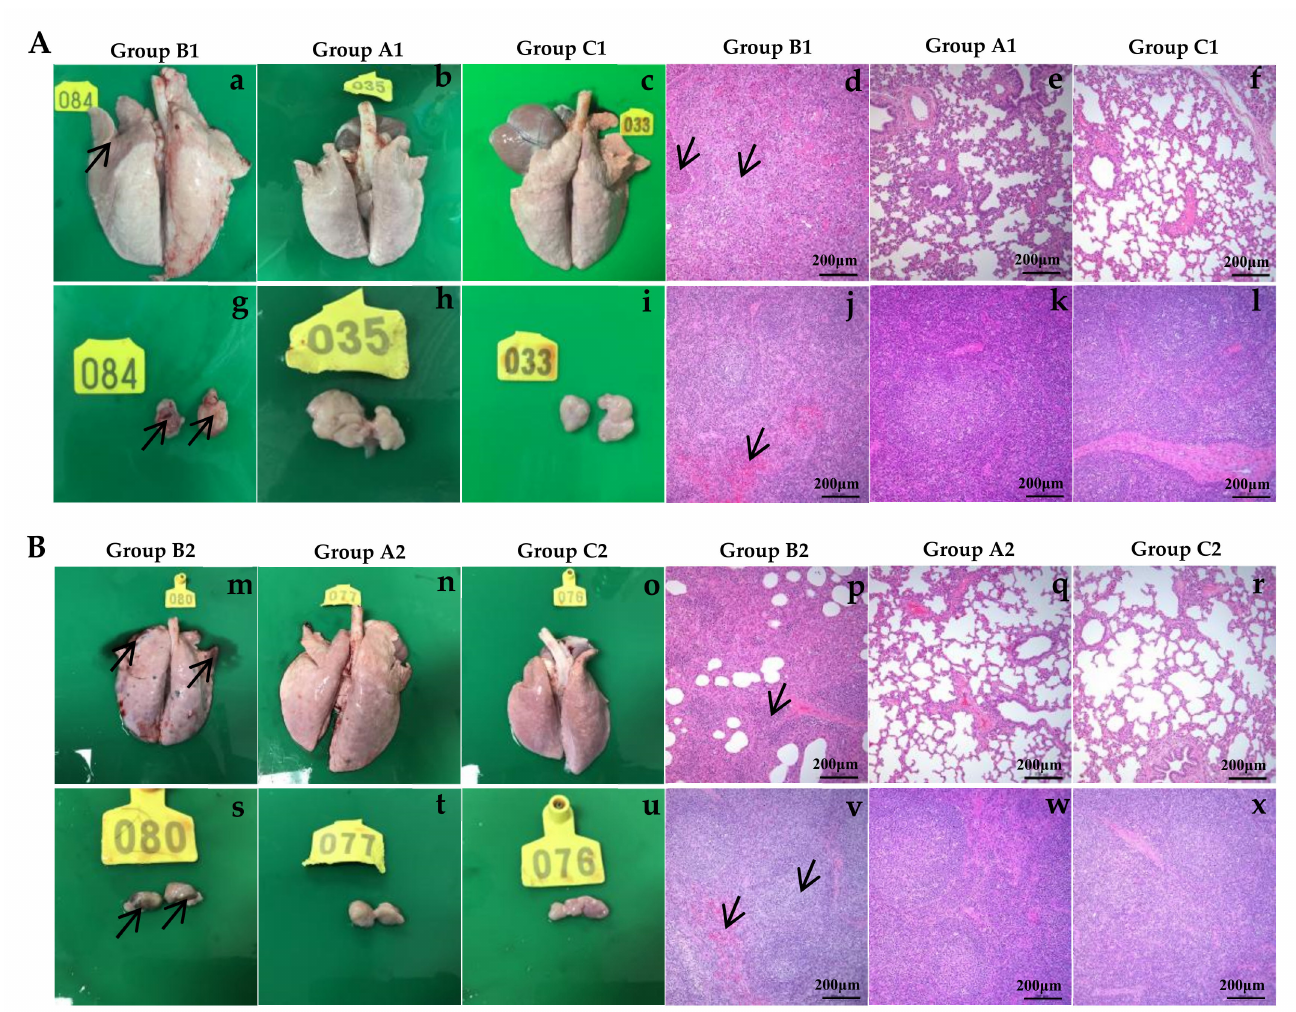
Figure 7. Gross and histological lesions of lungs and lymph nodes from SD-R immunization and challenge with parental virus SD group ( A ) and NADC30-like PRRSV HLJWK108-1711 group ( B ). Consolidation and/or oedema in the lungs in groups B1 and B2 (a and m), and hemorrhage in the lymph nodes in groups B1 and B2 (g and s) were observed when compared with groups A1 and A2 (b and n; h and t) and groups C1 and C2 (c and o; i and u). Compared with groups A1 and A2 (e and q) and groups C1 and C2 (f and r), a large amount of inflammatory cell infiltration, epithelial cell proliferation and significant alveolar diaphragm widening in the lungs were observed in groups B1 and B2 (d and p). Compared with groups A1 and A2 (k and w) and groups C1 and C2 (l and x), mild lymphocytopenia and medullary hemorrhage were observed in parts of the lymphoid nodules in groups B1 and B2 (j and